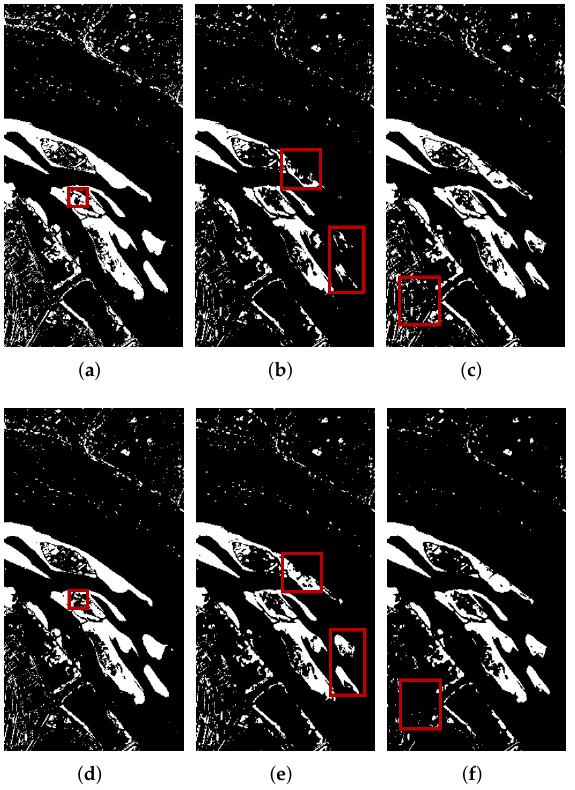
Figure 12. Results of different networks in the first and last iterations on River dataset. ( a ) GETNET in the first iteration. ( b ) 2DCNN in the first iteration. ( c ) 3DCNN in the first iteration. ( d ) GETNET in the last iteration. ( e ) 2DCNN in the last iteration. ( f ) 3DCNN in the last